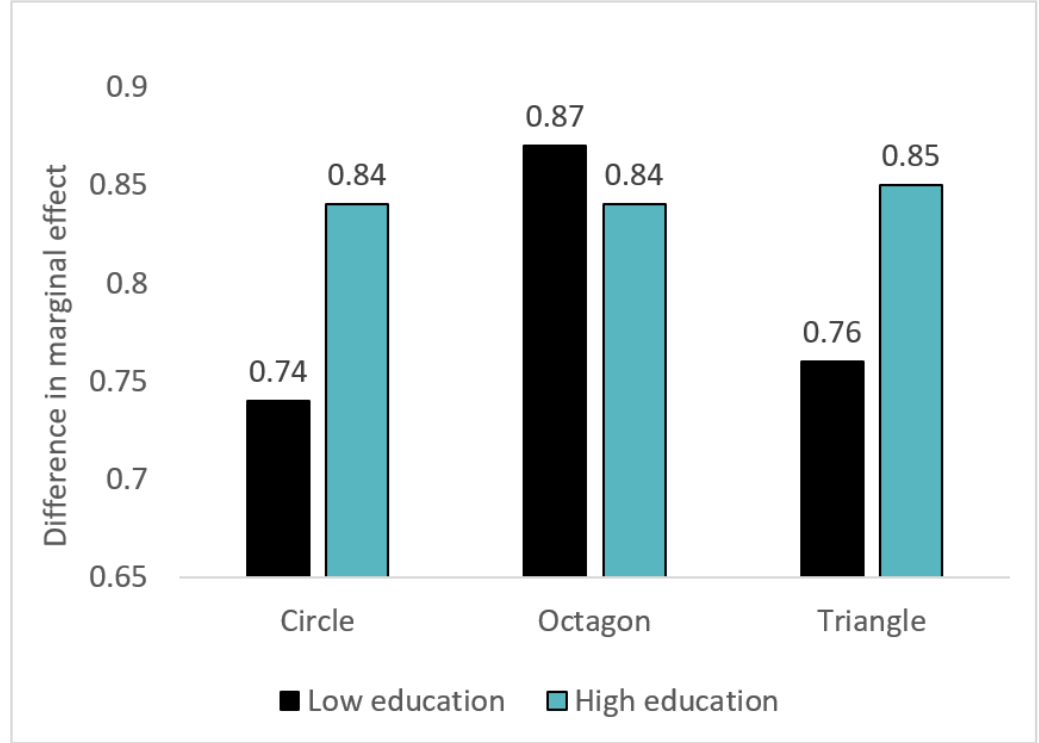
Figure 3. Di ff erence in marginal e ff ect of warnings compared to the control label on perceived message Figure 3. Difference in marginal effect of warnings compared to the control label on perceived e ff ectiveness (PME) in high versus low education. Note. p -value for joint chunk test for the interaction message effectiveness (PME) in high versus low education . Note. p- value for joint chunk test for the of warning label types and education = interaction of warning label types and education = 0.412.